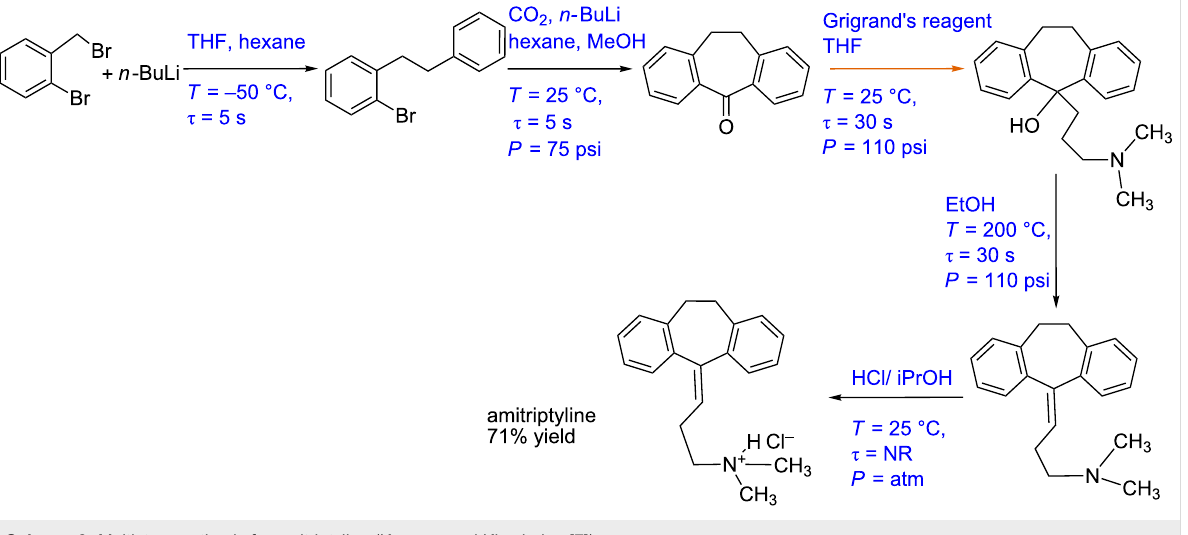
Scheme 8: Multistep synthesis for amitriptyline (Kupracz and Kirschning